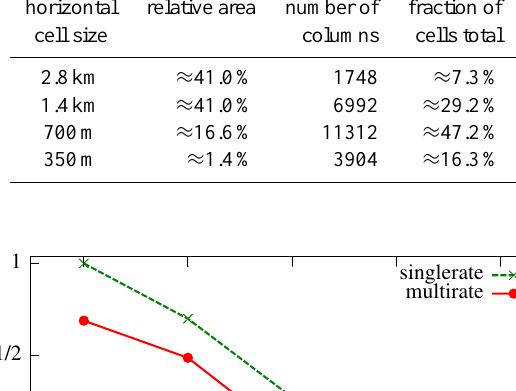
Fig. 8. Illustration of the spatial structure for realistic test run.